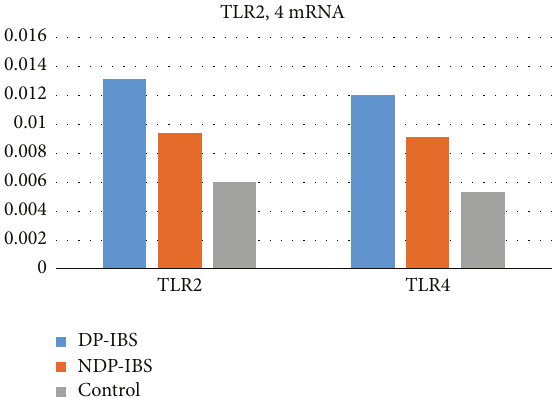
Figure 3: TLR2 and TLR4 mRNA expressions in DP-IBS, NDP-IBS, and the control group (0.013 ± 0.002, 0.009 ± 0.003, and 0.006 ± 0.002, resp., 𝐹 = 5.018 , 𝑃 = 0.008 ; 0.012 ± 0.002 , 0.009 ± 0.001 , and 0.005±0.001 ,resp., 𝐹 = 12.015 , 𝑃 < 0.01 ).TheTLR2mRNAlevelsin DP-IBS and NDP-IBS patients were significantly higher than those in the control group, and those in DP-IBS patients were significantly higher than those in NDP-IBS patients ( 𝑃 < 0.05 ). TLR4 mRNA levels in DP-IBS and NDP-IBS patients were significantly higher than those in the control group, and those in DP-IBS patients were significantly higher than those of NDP-IBS patients ( 𝑃 < 0.05